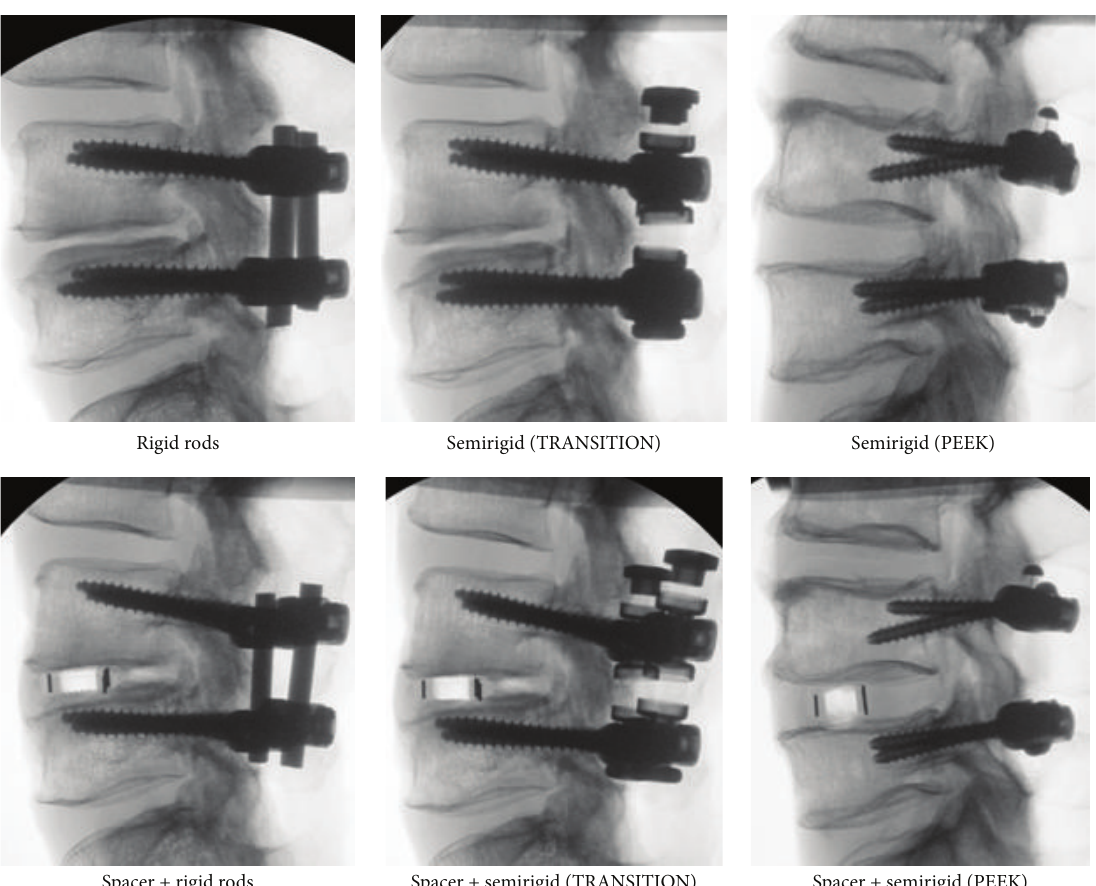
Figure 6: Select radiographs from flexibility testing, showing rigid and semirigid